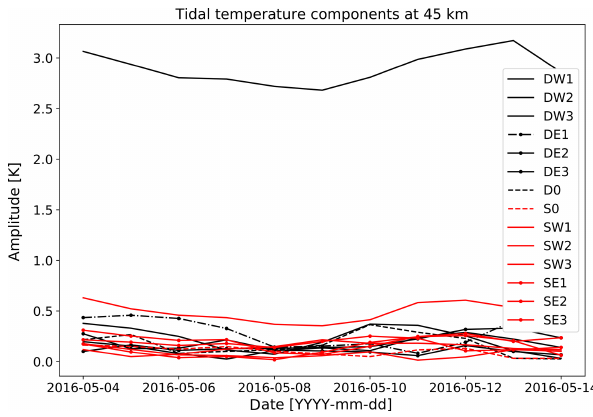
Figure 12. Tidal temperature modes at 45km altitude from global MERRA-2 fields at the latitude of 54 ◦